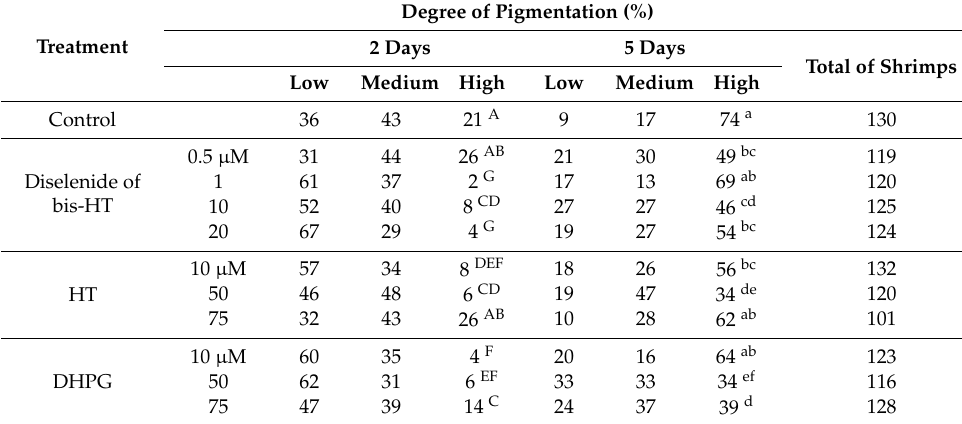
Different letters (a–f) indicate significant difference among groups at p ≤ 0.05 for each of experiments. Capital letters (A–F) (A–G) for 2 days and lower letters (a–f) for 5